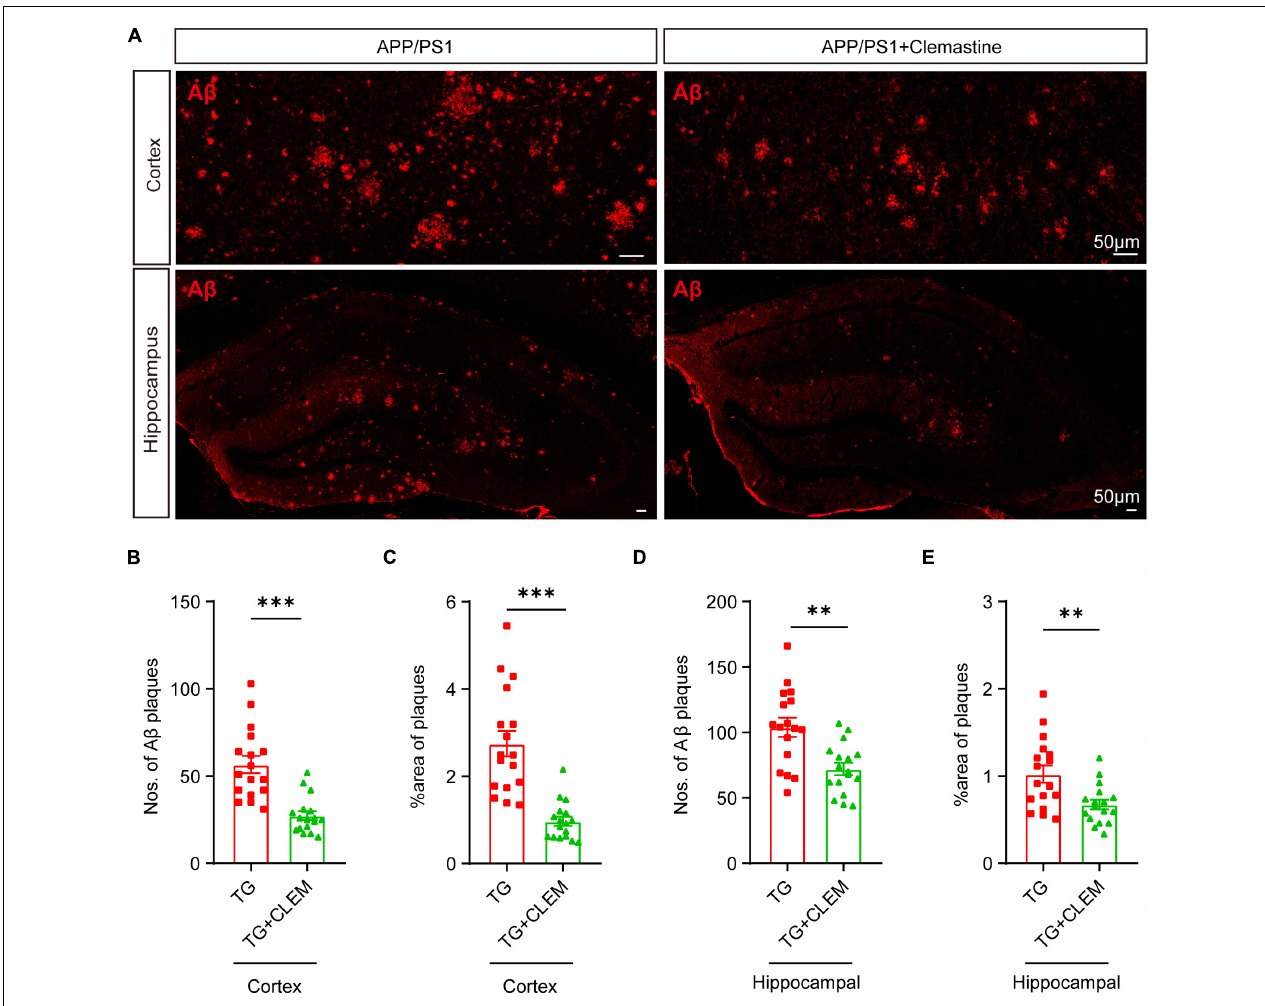
FIGURE 2 | Chronic treatment of clemastine ameliorates accumulation of A β in aged APP/PS1 mice brain. (A) Confocal images of immunolabeling of A β (red) in hippocampus/cortex of APP/PS1 and APP/PS1 mice treated with clemastine. (B–E) Quantification of numbers of A β plaque and percentage of A β plaque covering areas of hippocampus (B,C) /cortex (D,E) as shown in (A) . All brain sections were collected from 17-month-old mice. Values shown represent mean ± SE. ∗∗ p < 0.01, ∗∗∗ p < 0.001, n = 4 mice per group, one-way analysis of variance with Student’s t